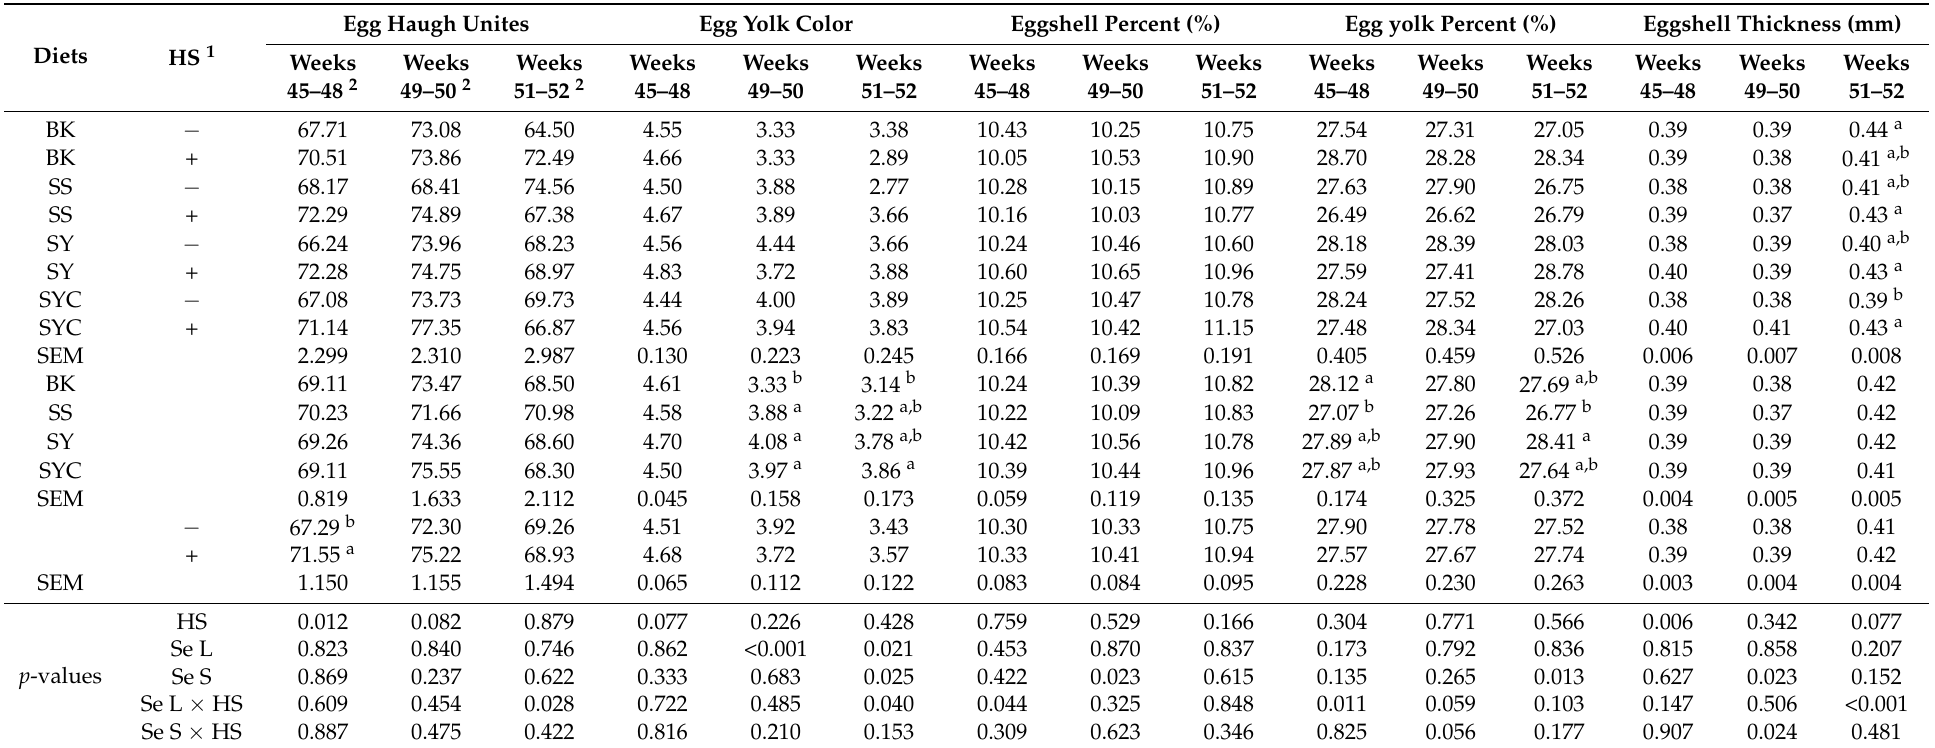
Different letters indicate statistically significant differences ( p < 0.05). BK: basal diet, SS: sodium selenite, SY: selenium yeast, SYC: selenium-enriched yeast culture, Se L: selenium levels, and Se S: selenium sources. 1 HS − = Normal temperature (26 ± 2 ◦ C), HS+ = Circulating high temperature (26 ± 2 ◦ C~33 ± 2 ◦ C). 2 Weeks 45–48, 49–50, and 51–52: each group has six replicates ( n =